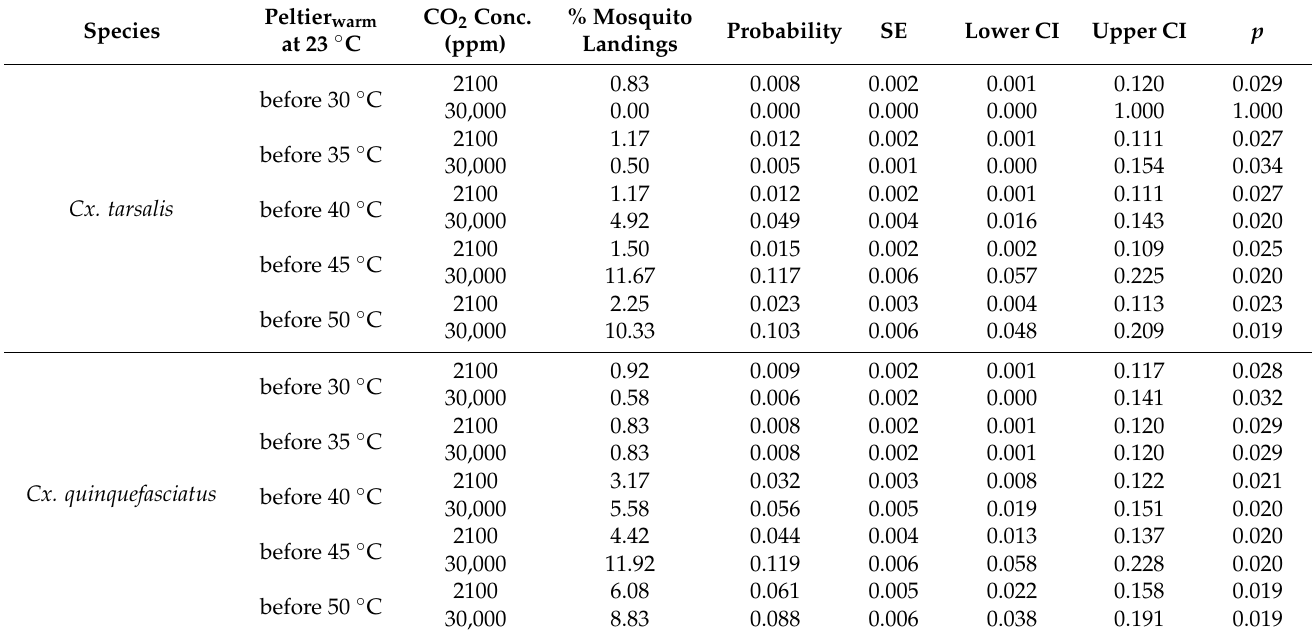
Table 3. Proportion of mosquito landings on Peltier warm at 23 ◦ C before every thermal stimulus in the heat-seeking